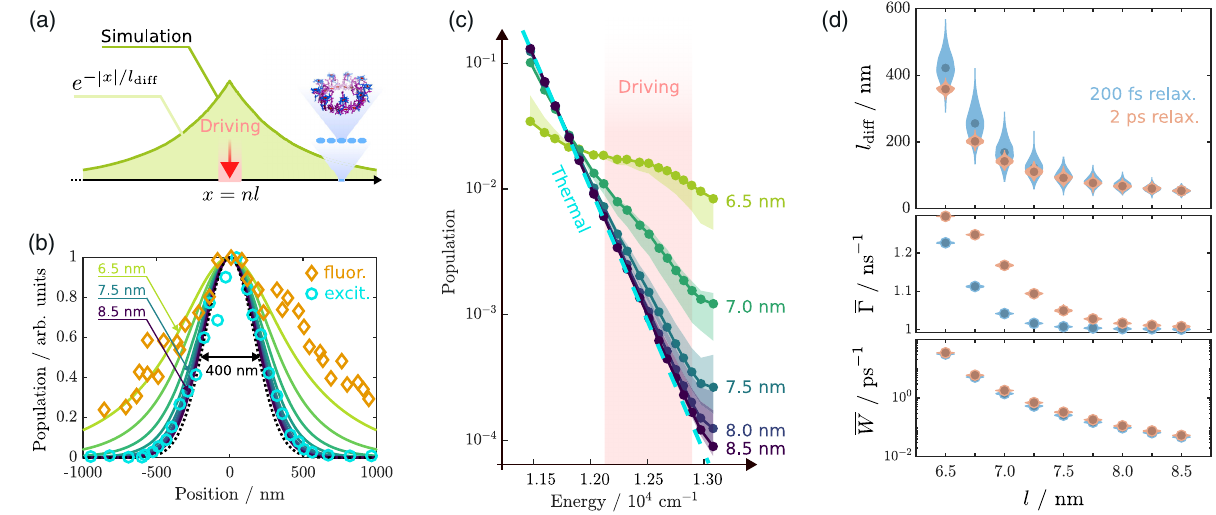
FIG. 3. Exciton propagation across a chain of LH2 units. (a) Energy transfer in a linear array of 1001 coplanar LH2 complexes subject to local driving results in an exponential population distribution. Intercomplex distances can vary between roughly 6.5 nm in nano- engineered arrays and 8.5 nm in biological membranes, resulting in inter-ring transfer rates W αβ ≃ ð 1 – 10 ps Þ − 1 in typical physiological settings. Intracomplex dynamics is governed by interexciton dephasing and relaxation R αα 0 , with a typical timescale of 200 fs. (b) Spatial exciton distribution for distances l ranging from 6.5 nm to 8.5 nm (green to violet lines), upon Gaussian driving with 400 nm full width at half maximum (black dotted line). The simulations for l ¼ 6 . 5 nm agree with the experimental data taken from Ref. [20] (circles: excitation profile; diamonds: fluorescence profile). (c) Nonequilibrium energy distribution of exciton population averaged across the linear array for different distances l (dots). The shaded areas represent the range in which the distribution varies when moving from the center to the ends of the array. The injection at the central ring takes place around 12 500 cm − 1 from the B800 ring (pink shaded area). At small l , the population deviates from the Boltzmann distribution (dashed line), and transfer effectively proceeds out of thermal ¯ Γ ¯ W equilibrium. (d) Distance dependence of effective diffusion length l (top), decay rate (center), and transfer rate (bottom). Their diff full distributions (patches) are shown together with their average (dots). LH2 arrays take advantage of fast local exciton thermalization (blue) to achieve longer-distance — albeit slower — energy transfer, compared to a hypothetical scenario with weaker coupling to local phonons (orange). All averages are performed over 10 3 realizations of static